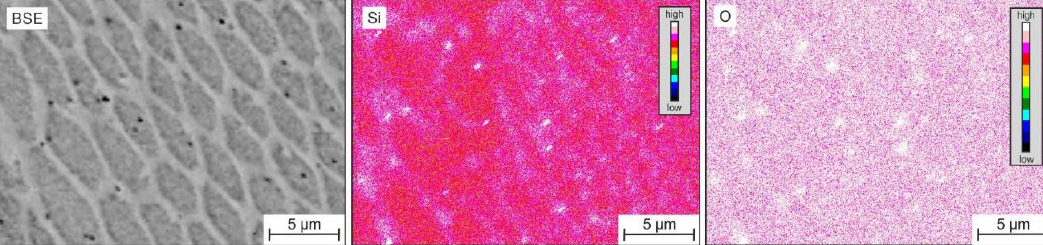
Figure 7. Qualitative EDS element mapping shows silicon-rich oxide inclusions in the LMD specimen. The BSE image corresponds to another position in the microstructure.